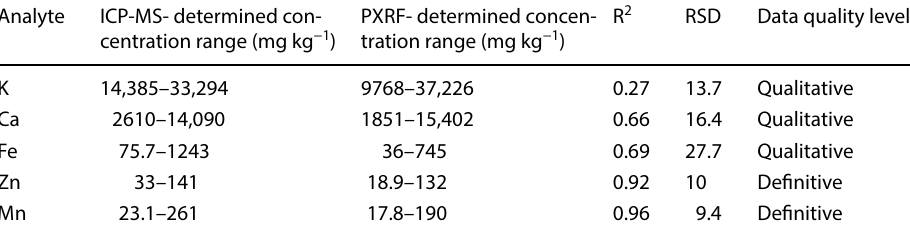
Total number of paired samples in which both the ICP-MS and PXRF analyzers detected the specified analyte